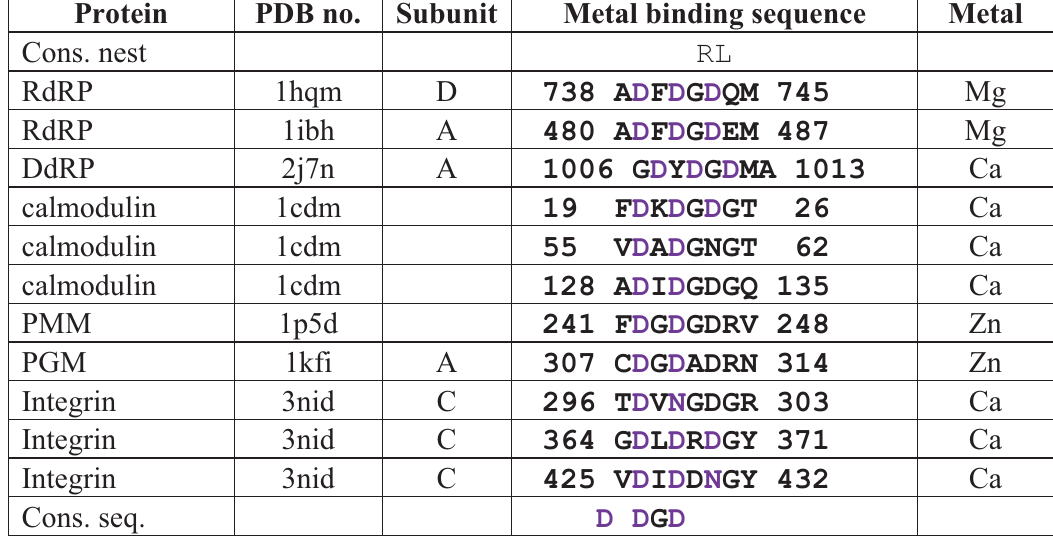
Table 2. Homologous metal-binding sites in various proteins. All have an RL nest at the same position, shown in the top row. It is suggested that this structural feature is functionally useful in binding the carboxylate groups. RdRP means RNA-dependent RNA polymerase. DdRP means DNA-dependent RNA polymerase. PGM means Metal binding